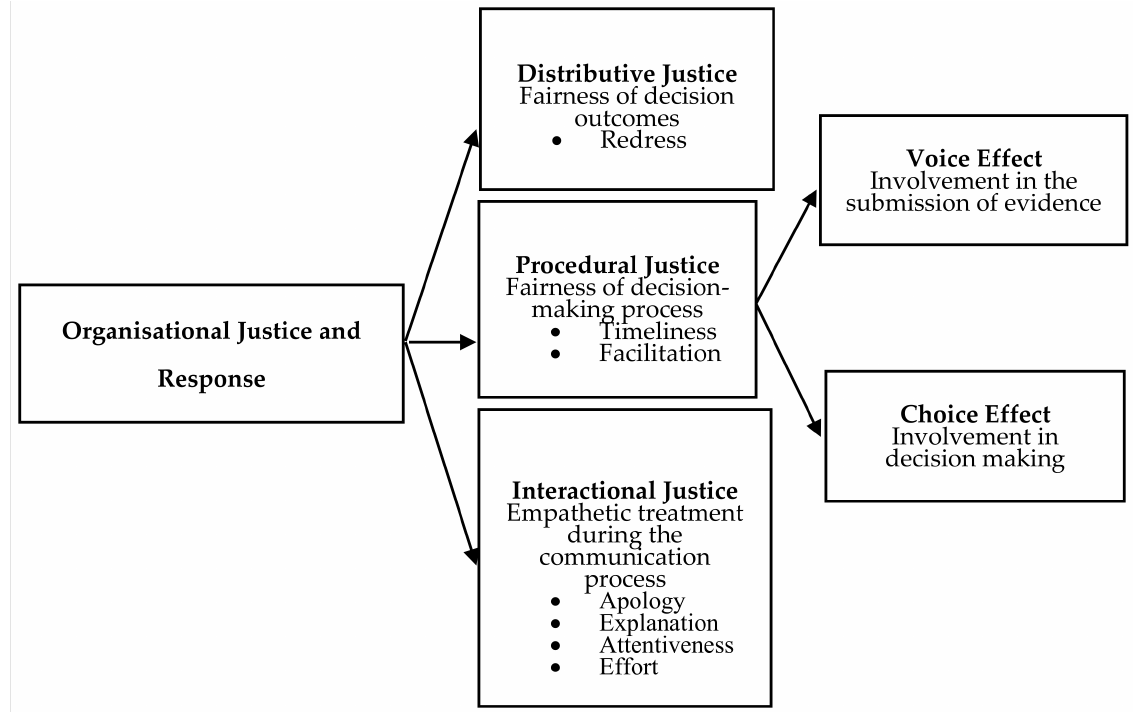
Figure 1. Dimensions of organisational justice and response theory. Adapted from Abisuga et al.